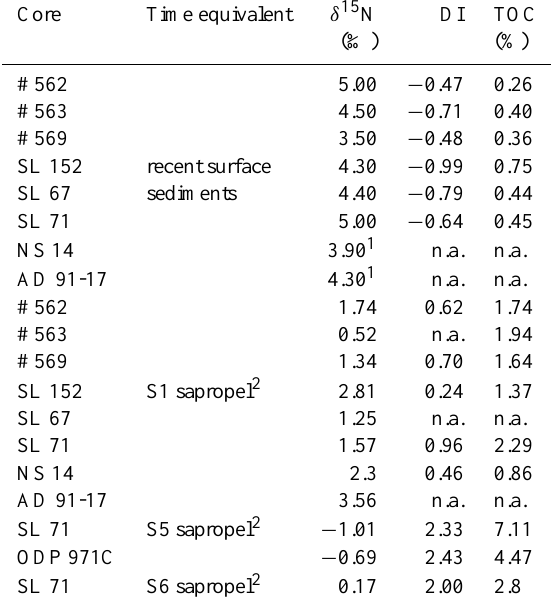
Table 4. δ 15 N, DI and TOC values of recent surface sediments (0 to 1cm) as well as from S1, S5 and S6 sapropel interval ( 1 = estimated values; 2 = mean values of entire